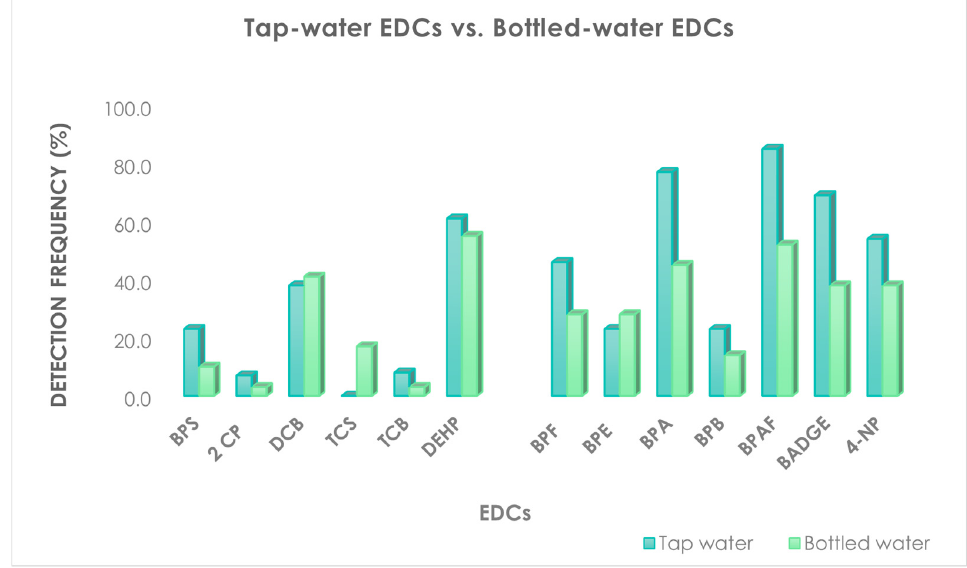
Figure 3. Detection frequency of each investigated chemicals in tap water vs. bottled waters .